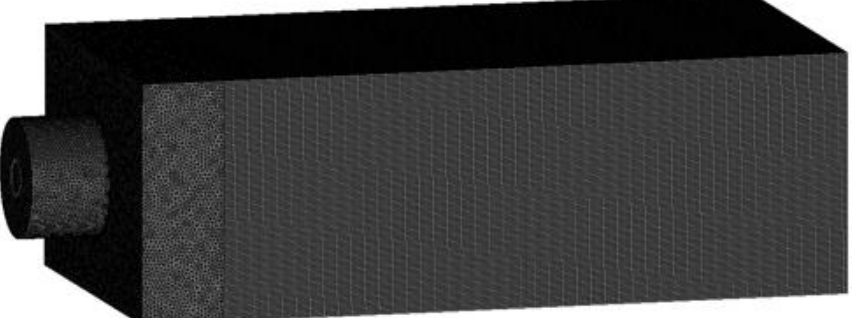
Figure 13. Computational mesh for CFD model.